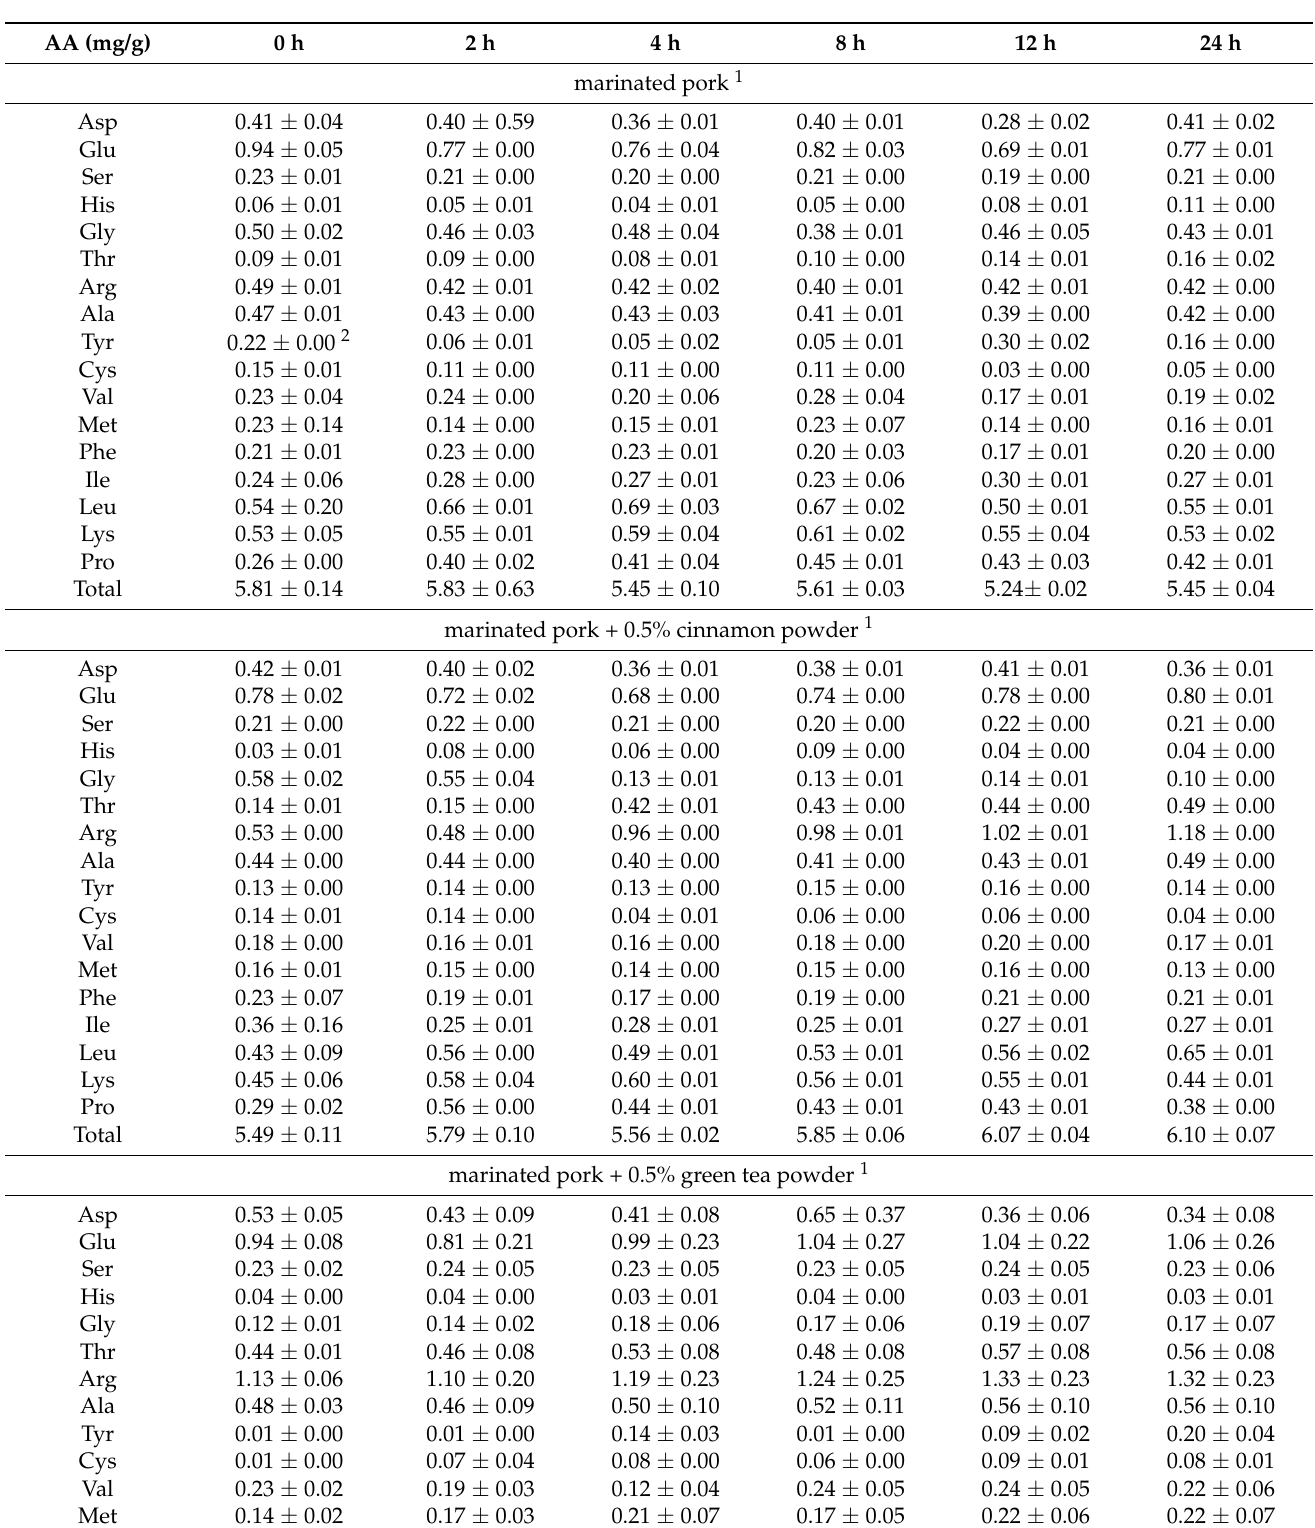
Table 2. Individual and total amino acid (AA) contents in unmarinated/marinated pork and juice as affected by different flavorings and time